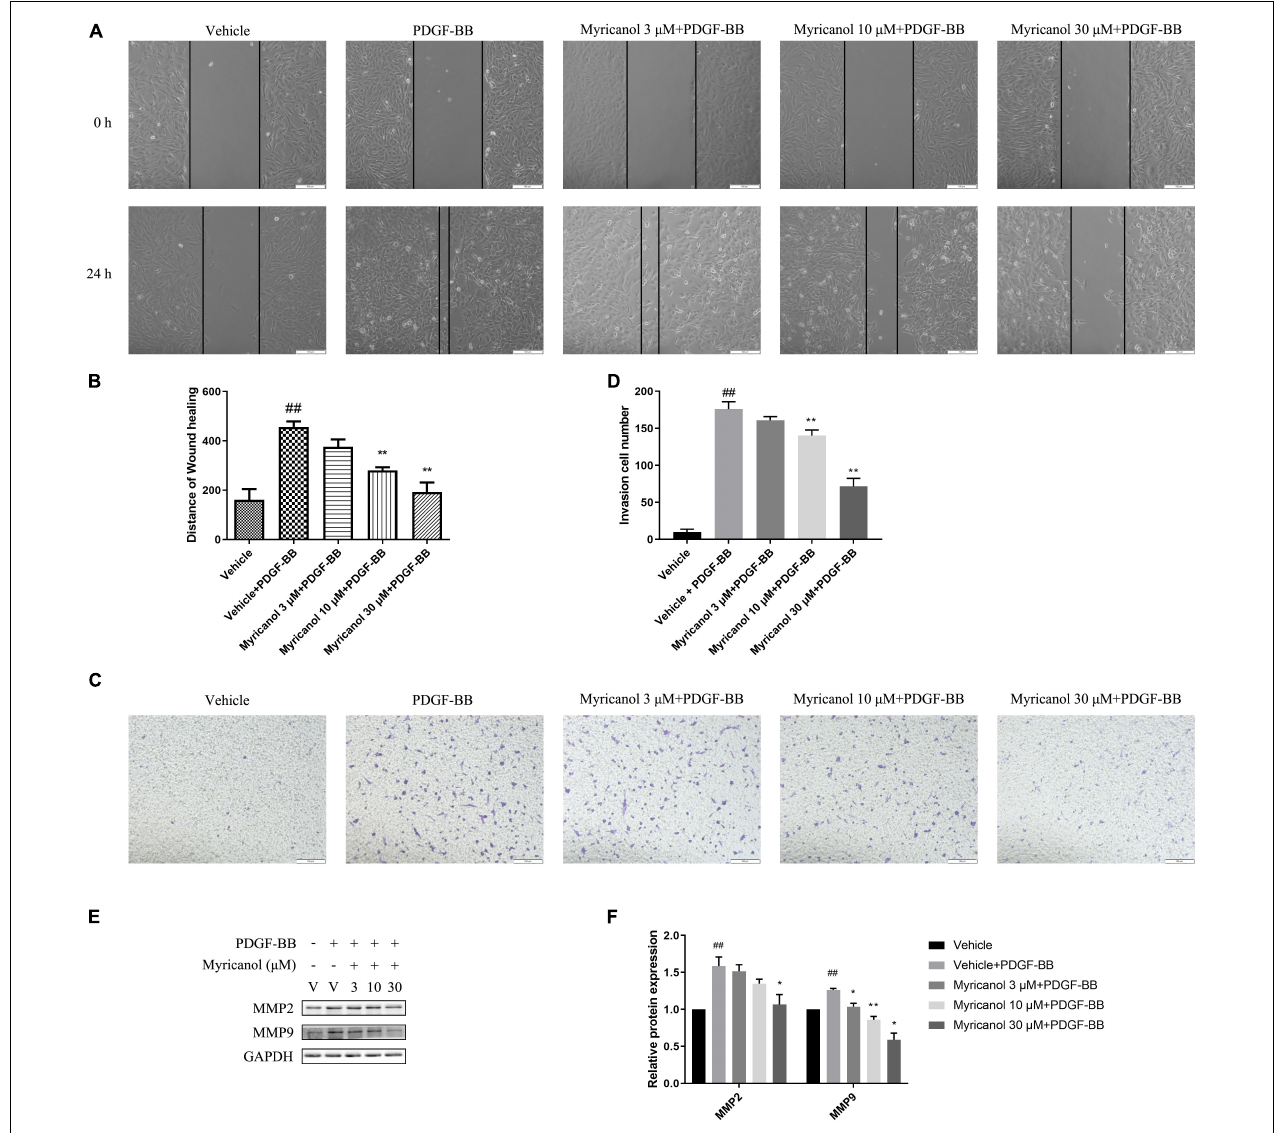
FIGURE 2 | Myricanol inhibits VSMCs migration. (A) In starvation conditions, cells were treated with indicated concentrations myricanol or not for 30 min, then scratched and treated with PDGF-BB (30 ng/ml) for 24 h. Scale bar, 100 µ m. (B) Quantification of the area of wound closure (%). Data are represented as mean ± SEM ( n = 3). ## P < 0.01 vs. the Vehicle group. ** P < 0.01 vs. the Vehicle + PDGF-BB group. (C) After treated with PDGF-BB and myricanol for 24 h, a transwell migration assay of VSMCs was performed and representative images were shown. Scale bar, 100 µ m. (D) Quantification of migrated cells. Data are represented as mean ± SEM ( n = 3). ## P < 0.01 vs. the Vehicle group. ** P < 0.01 vs. the Vehicle + PDGF-BB group. (E) After being pretreated with indicated concentrations of myricanol or vehicle for 30 min, the cells were stimulated by PDGF-BB (30 ng/ml) for 24 h. The protein level of MMP2 and MMP9 were determined by Western blot analysis. (F) Quantification of the Western blot analysis. Data are represented as mean ± SEM ( n = 3). ## P < 0.01 vs. the Vehicle group. * P < 0.05, ** P < 0.01 vs. the Vehicle + PDGF-BB